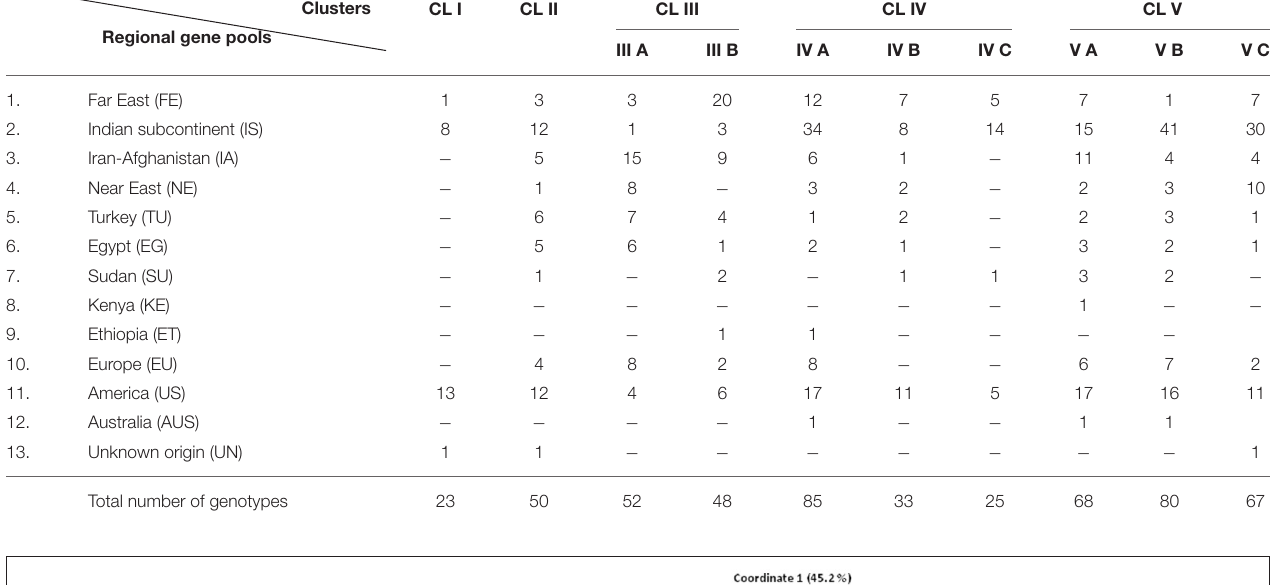
Regional gene pools